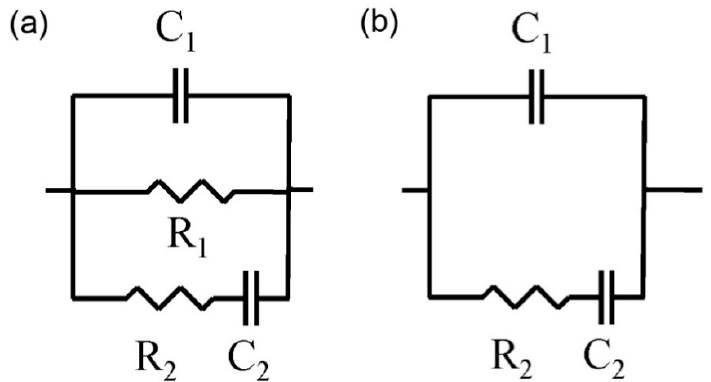
Figure 2. ( a ) Equivalent circuit used for the fitting of the impedance spectra obtained using the contacting method. ( b ) Equivalent circuit used for the fitting of the impedance spectra obtained using the non-contacting method. R = resistance; C =